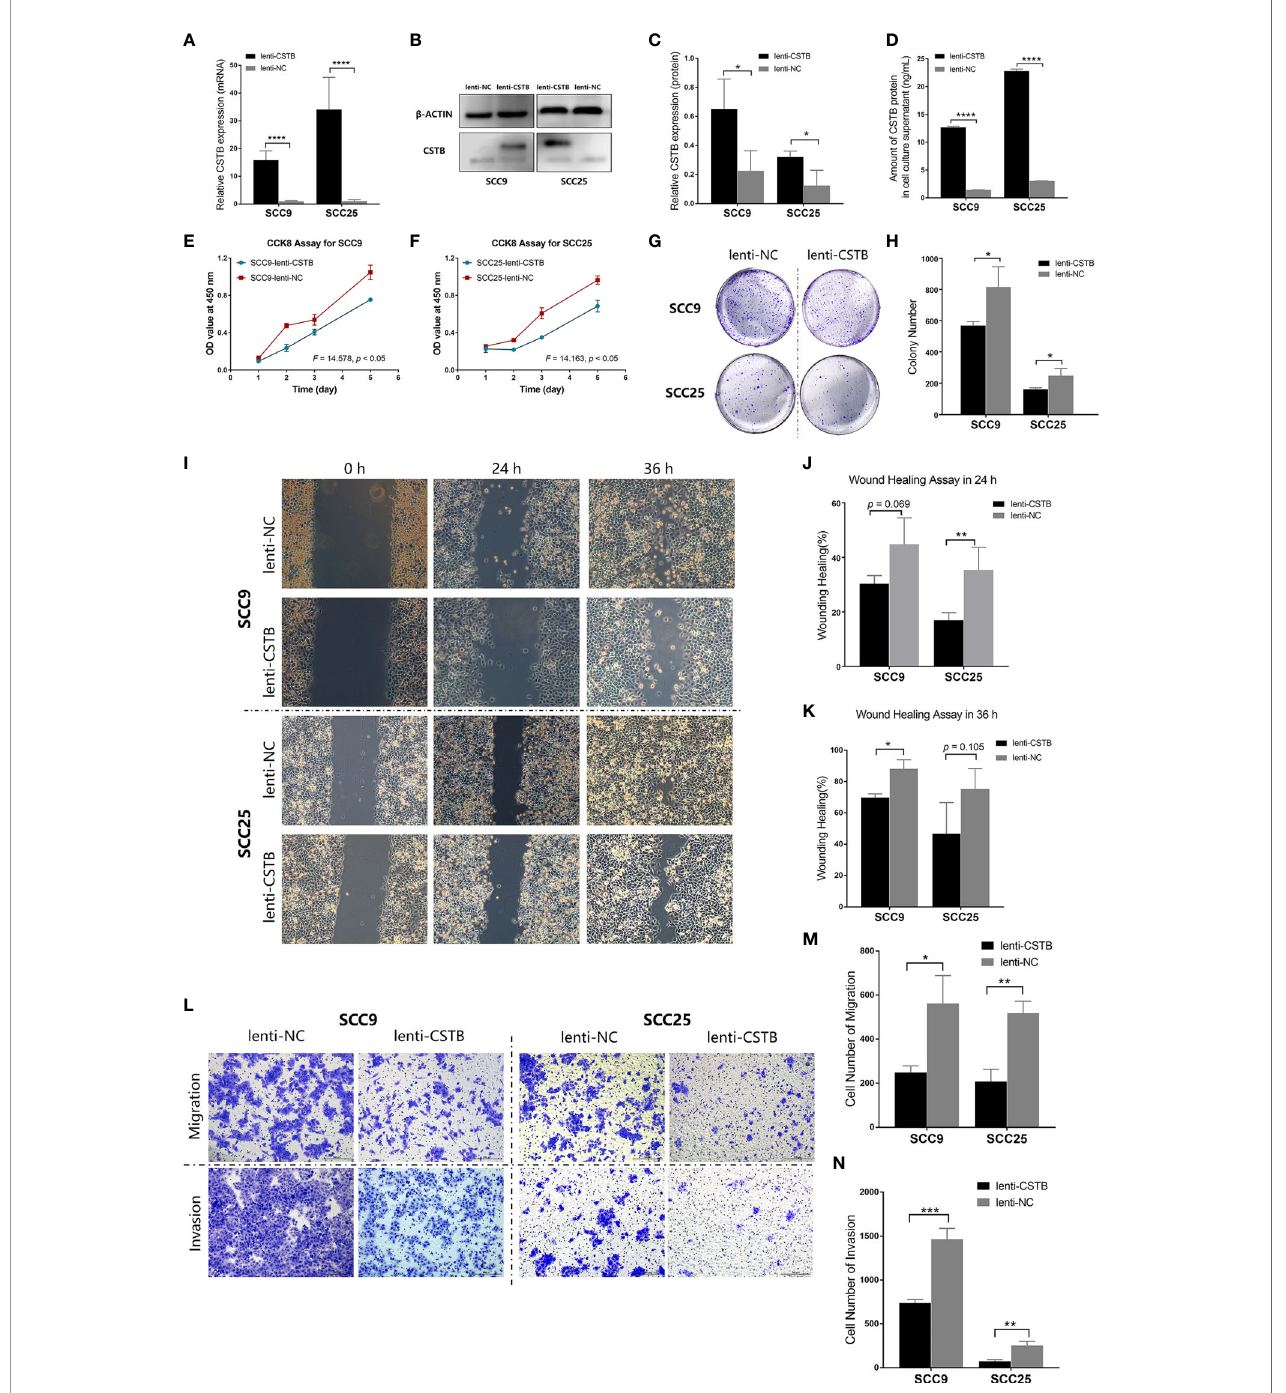
FIGURE 3 | Upregulation of CSTB inhibits the proliferation, migration, invasion and adhesion of OSCC cell lines. (A) Relative expression of CSTB mRNA in OSCC cell lines after lentivirus transfection. (B, C) CSTB protein expression in OSCC cell lines after lentivirus transfection was identi fi ed by Western blot analysis (B) and quantitatively analyzed (C) . (D) The content of CSTB in the culture supernatant of OSCC cell lines after lentivirus transfection was quanti fi ed by ELISA. (E, F) CCK8 assays for transfected OSCC cell lines. (G, H) Colony formation assays for transfected OSCC cell lines. (G) The representative staining images of each group; (H) the number of clones formed in each group. (I – K) Wound-healing assays for transfected OSCC cell lines. Representative images in (I) and statistical results in (J, K) at 0, 24, and 36 h in each group. (L – N) Transwell assays for transfected OSCC cell lines. Representative images for cell migration and invasion of each group are shown in (L) . Statistical results for cell migration and invasion are shown in (M, N) , respectively. Error bars represent the standard deviation. * p < 0.05, ** p < 0.01, *** p < 0.001, **** p <